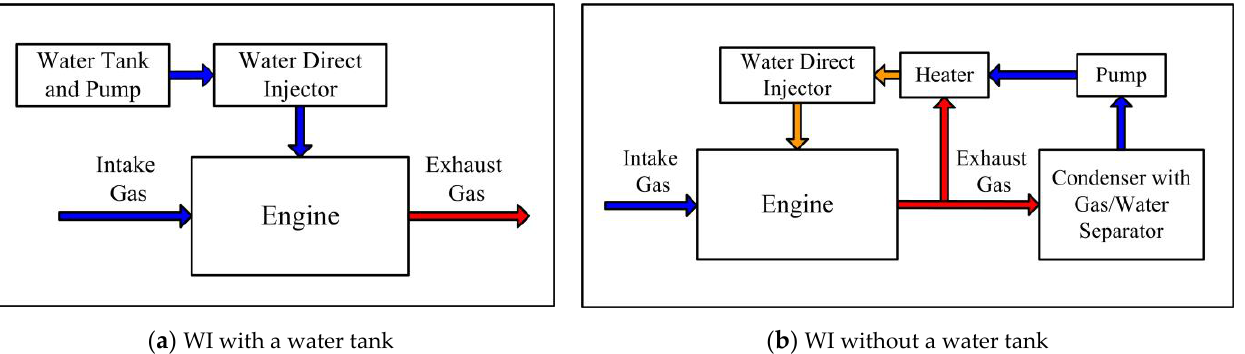
Figure 3. Schematic of typical WI systems in IC engines.